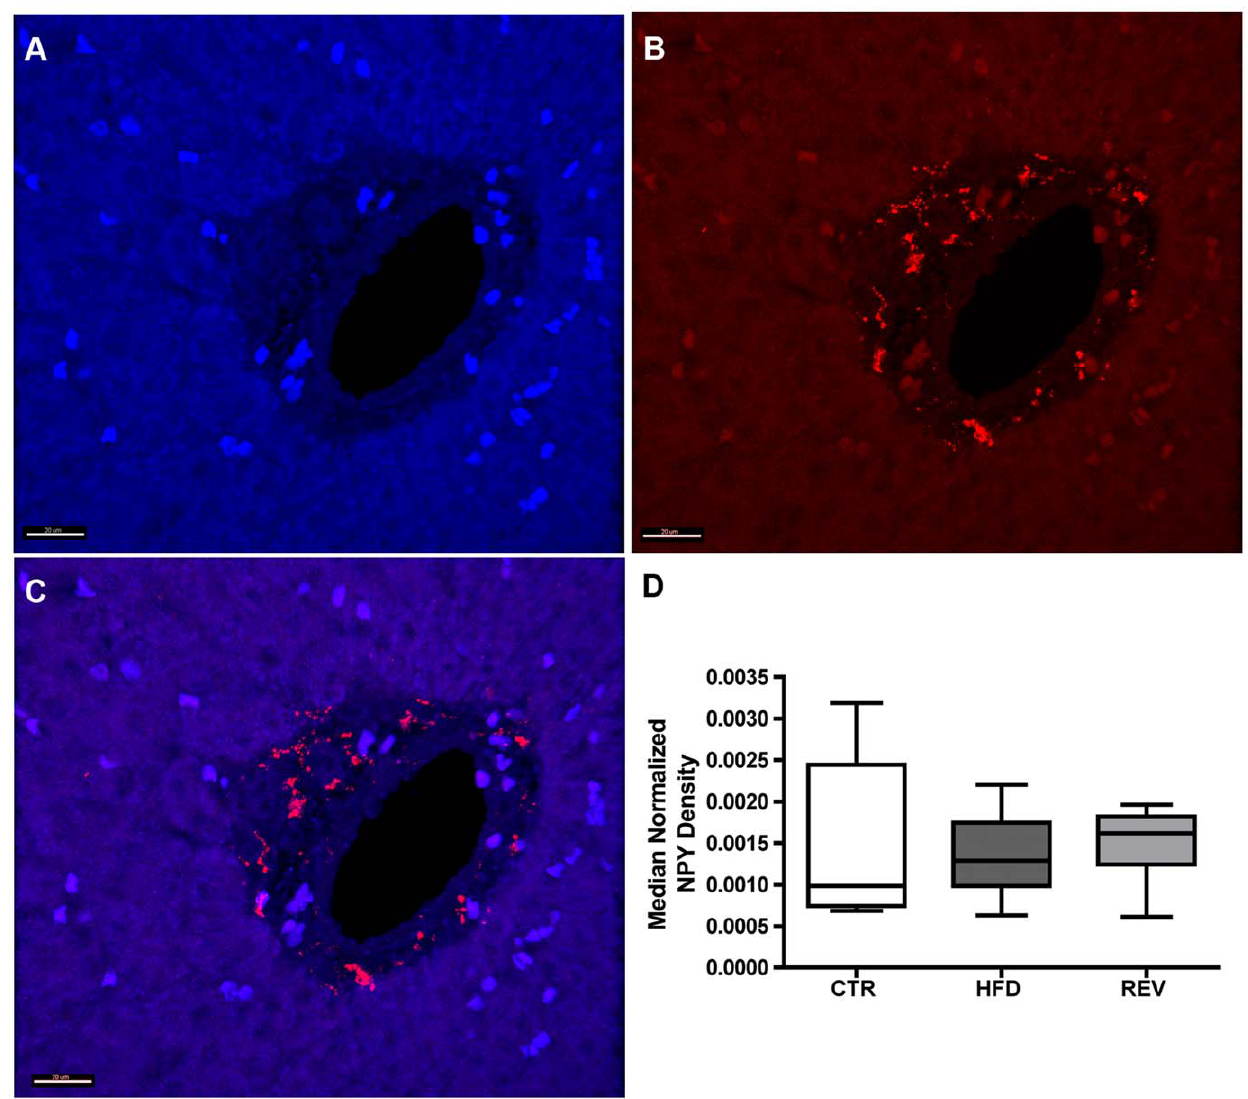
Figure 2. Visualization and quantification of the median density of portal NPY nerve fibers between maternal diet groups in the fetal macaque liver. (A) Tissue autofluorescence of a representative fetal portal region. (B) NPY immunofluorescence in the same portal region. (C) Overlay of NPY immunoreactivity with portal region. The volume of NPY immunoreactive fibers in each portal region (B) was quantified and normalized to the volume of hepatic tissue in each image (A). (D) No differences were observed in the density of NPY peptidergic innervation in fetal liver between maternal diet groups. Scale bar=20 m m. CTR; n=6, HFD; n=8, REV; n=7.